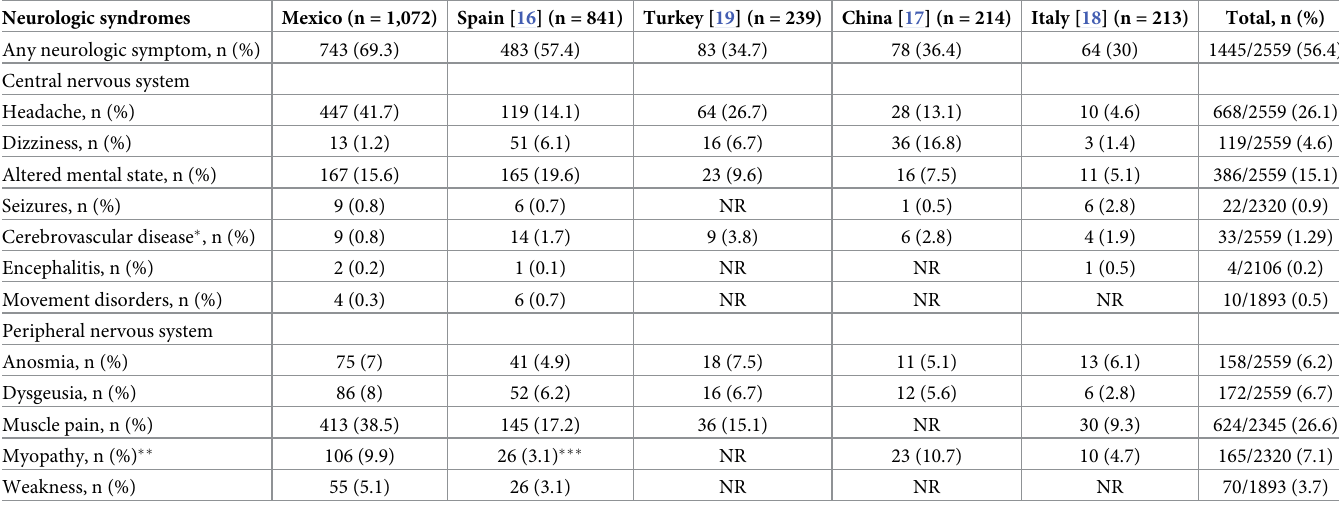
Table 5. Main neurologic manifestations reported among series of hospitalized patients with COVID-19. Neurologic